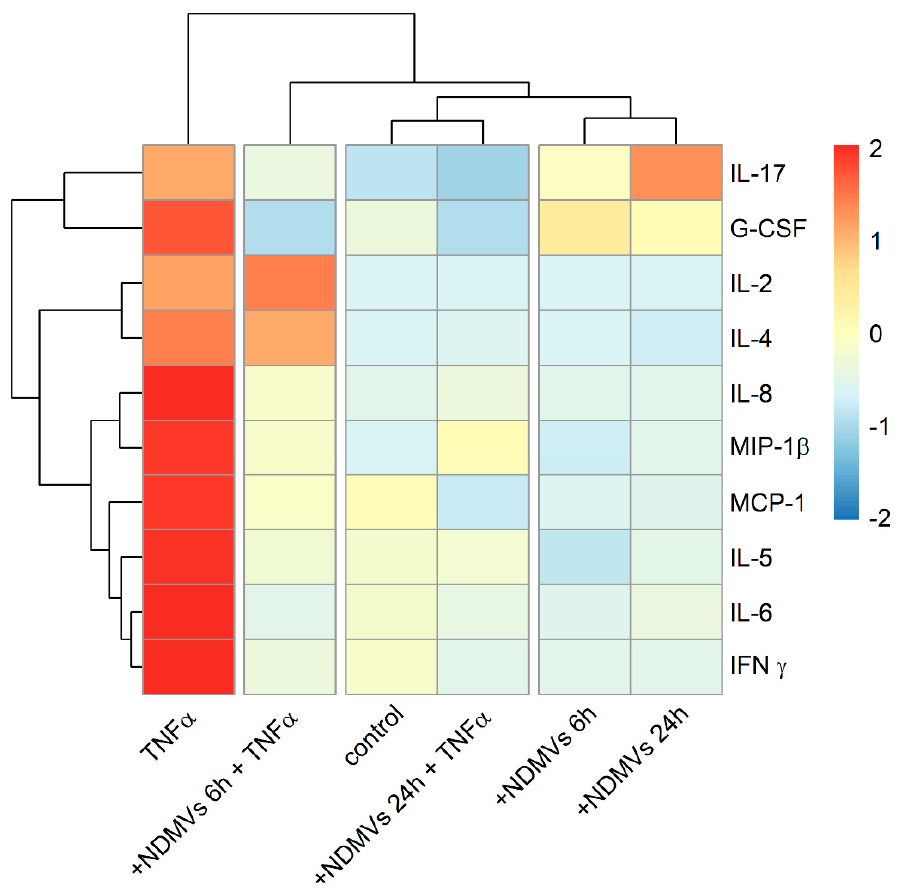
Figure 8. Heatmap of concentrations of proinflammatory cytokines in cultured media of FLS with/without NDMVs and TNF α . Median values were first standardized into Z-score based on each cytokine level in different groups. The hierarchical method was then used for cluster analysis on these standardized data. Color codes represent high (red), intermediate (white) and low (blue) expression.